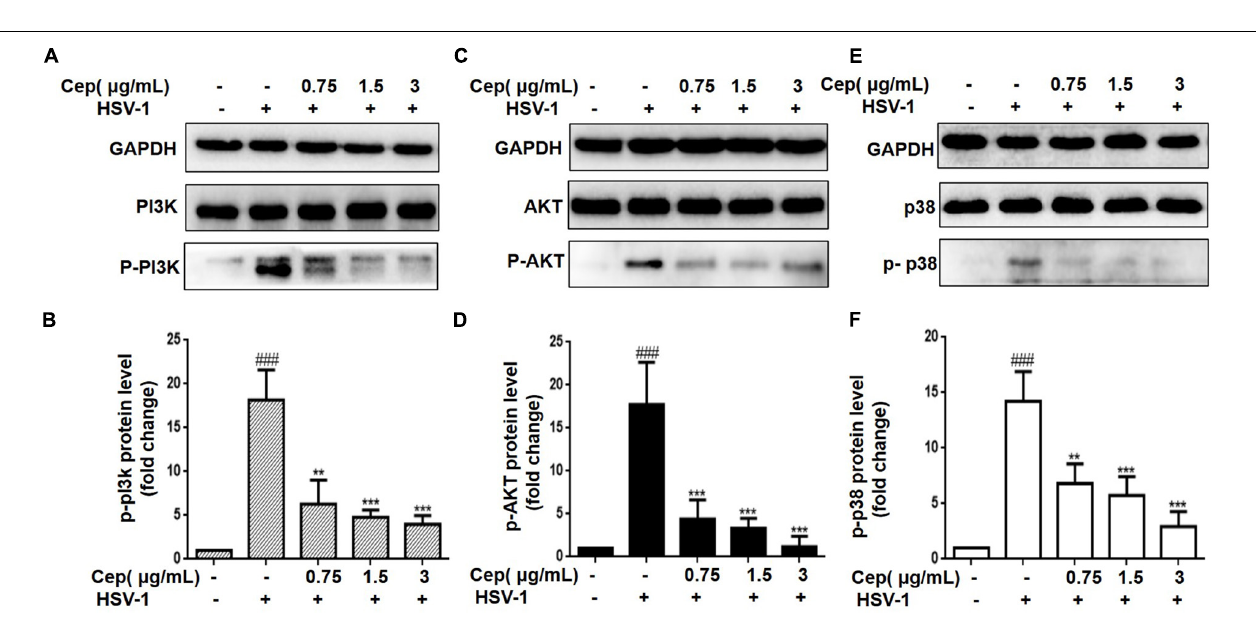
FIGURE 5 | The effect of CEP on PI3K/AKT and MAPK signaling pathway. (A–C) HSV-1 (MOI = 1) infected Hela cells were treated with CEP (3, 1.5, and 0.75 µ g/mL) for 36 h. Cell lysates were collected for Western blotting as indicated. (D–F) Results from three independent experiments were quantitated and presented as means ± SD. ### P < 0.001 indicates significant difference vs. NC group; ** P < 0.01; *** P < 0.001 indicates significant difference vs. model group.